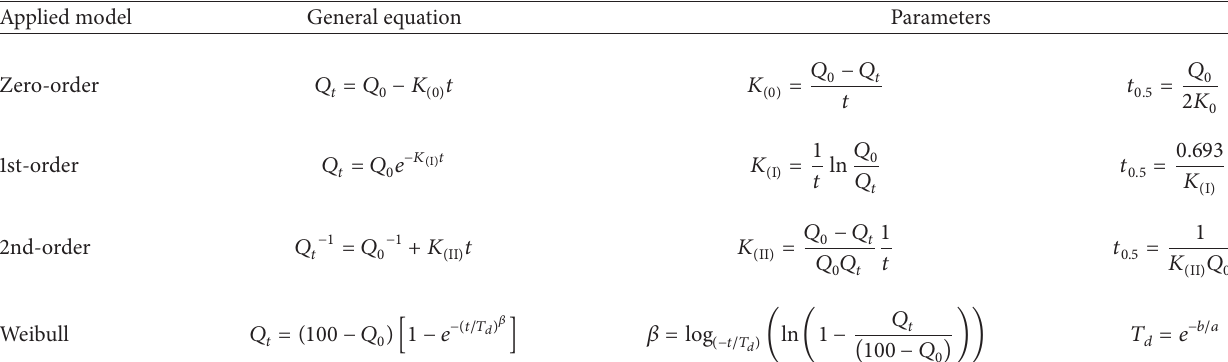
Figure 2: Schematic representation of applied hydrophilic polymers with various functional groups: (a) methylcellulose (MC), (b) polyacrylic acid derivatives (PA1 and PA2), and (c) polyacrylate crosspolymer 11 (PC-11). Table 2: Kinetic models applied for evaluation of obtained